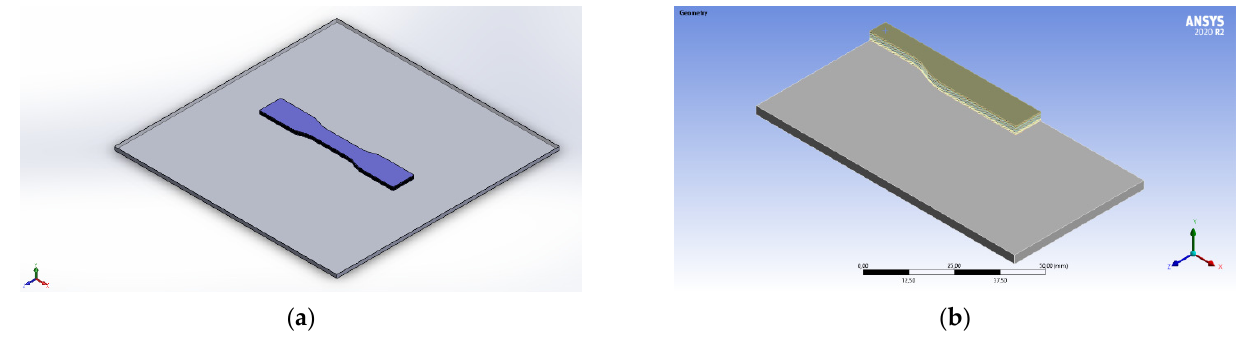
Figure 1. Problem domain ( a ) tensile test sample ( b ) quarter